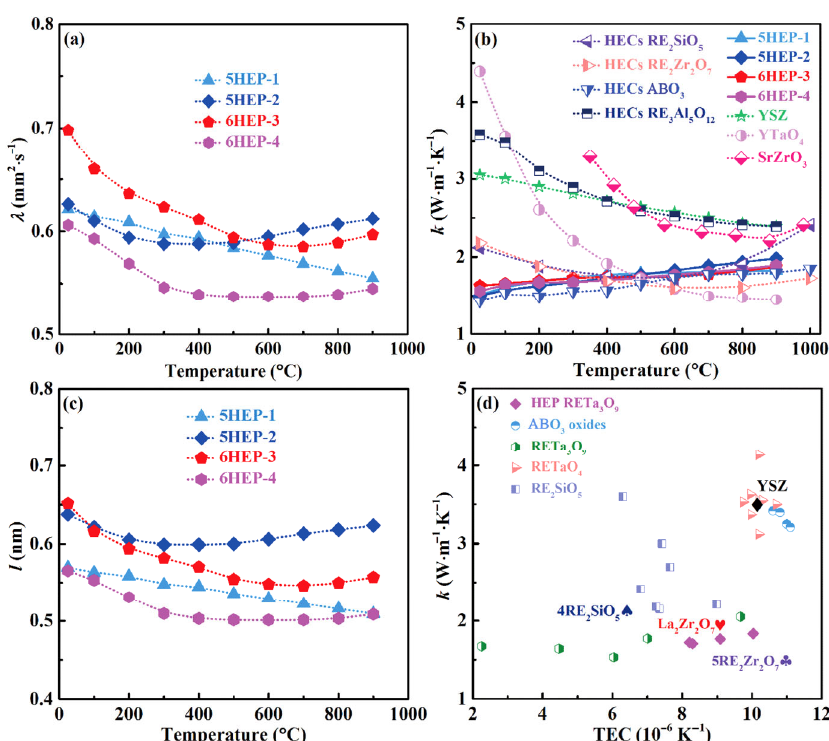
Fig. 8 Thermal properties of (La 1/5 Pr 1/5 Dy 1/5 Ho 1/5 Tm 1/5 )Ta 3 O 9 (5HEP-1), (Gd 1/5 Dy 1/5 Ho 1/5 Er 1/5 Tm 1/5 )Ta 3 O 9 (5HEP-2), (La 1/6 Sm 1/6 Eu 1/6 Dy 1/6 Ho 1/6 Tm 1/6 )Ta 3 O 9 (6HEP-3), and (Eu 1/6 Gd 1/6 Dy 1/6 Ho 1/6 Er 1/6 Tm 1/6 )Ta 3 O 9 (6HEP-4) ceramics: (a) thermal diffusivity, (b) thermal conductivity, (c) phonon mean free path, and (d) thermal properties compared with other oxides in Refs.